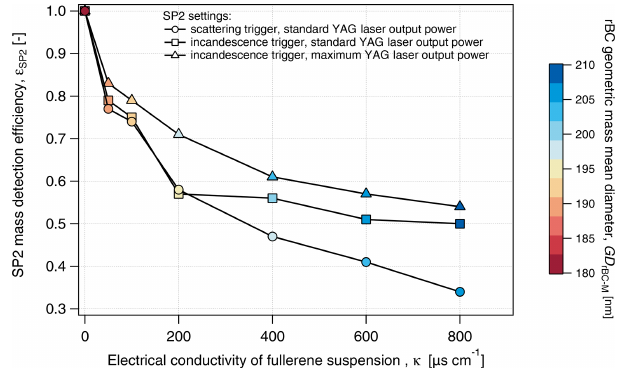
Figure 6. Mass detection efficiency of the SP2 for different SP2 set- tings and increasing electrical conductivity. Data are acquired from the analysis of a fullerene soot suspension at 10µgL − 1